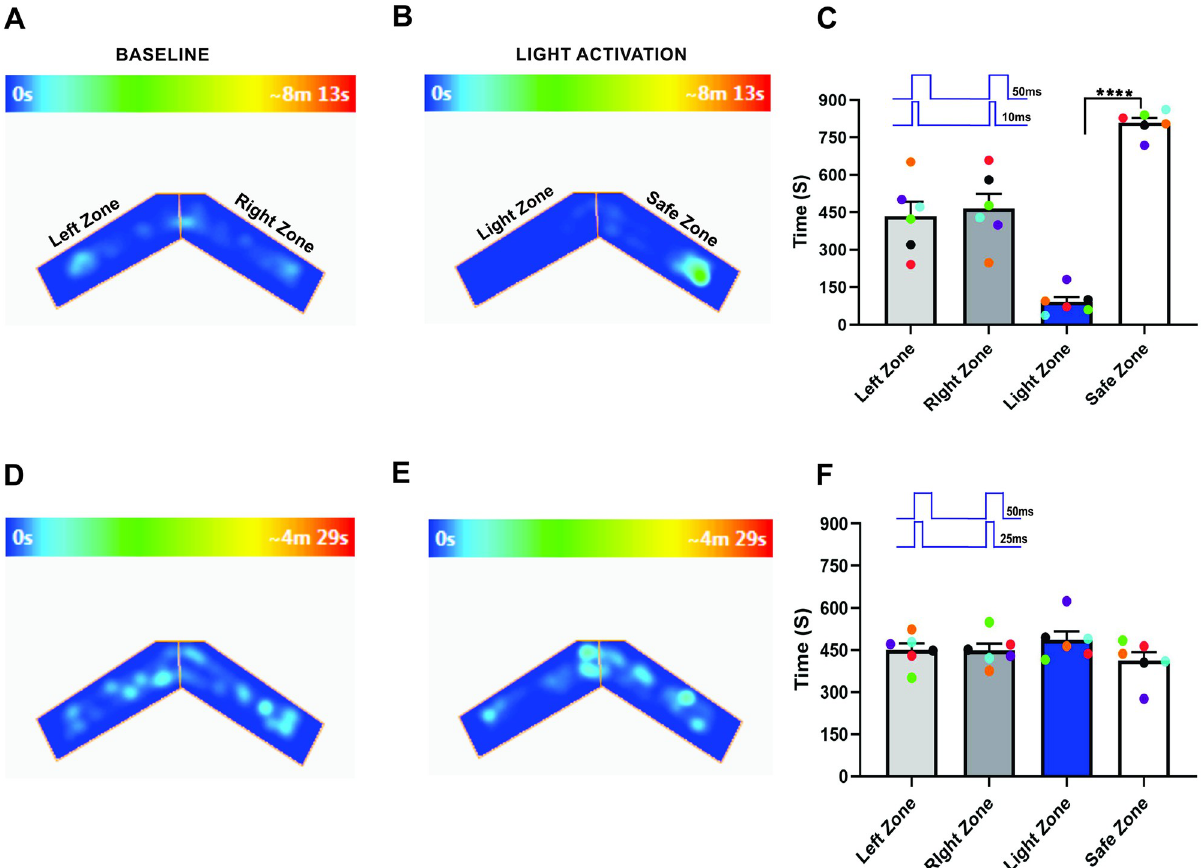
Fig 3. Bilateral input duration changes the unilateral olfactory information. A, B, an example of heat-map showing the animal’s position in the “two-arms maze” during baseline (A) and dual OB (50–10 ms) light stimulation (B). C, Average amount of time explored in each zone in baseline and dual OB (50–10 ms) light stimulation trials. D, E, Heat-map of mouse position during baseline (D) and dual OB (50–25 ms) light stimulation (E). F, Average amount of time spent in each zone in baseline and dual OB (50–25 ms) light stimulation trials. ( ���� P < 0.0001, n = 6 animals).